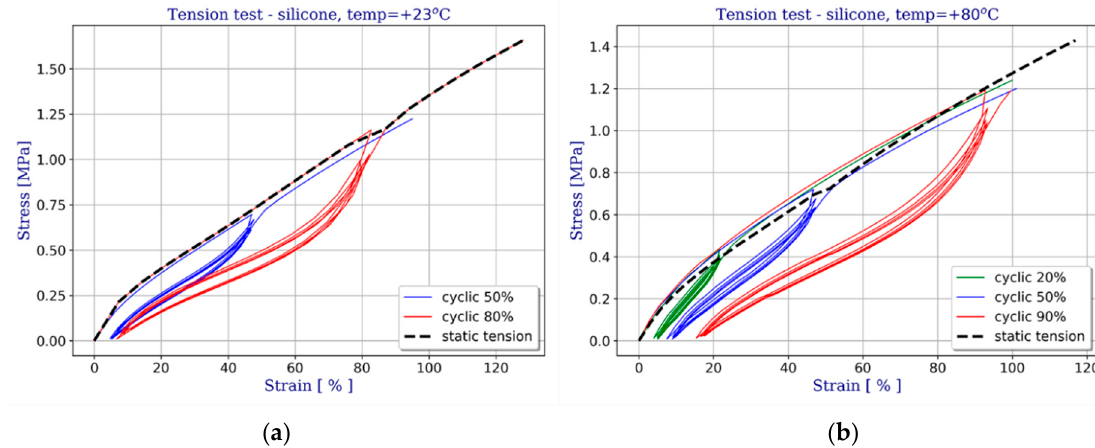
Figure 9. Results of uniaxial cyclic tension tests at different stress levels and different temperatures: ( a )T = 23 °C; ( b ) T = 80 °C.